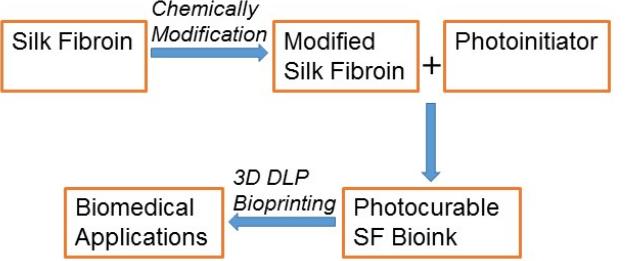
Figure 1. Schematic overview of the biomedical application of the SF-based bio-ink via 3D DLP printing.